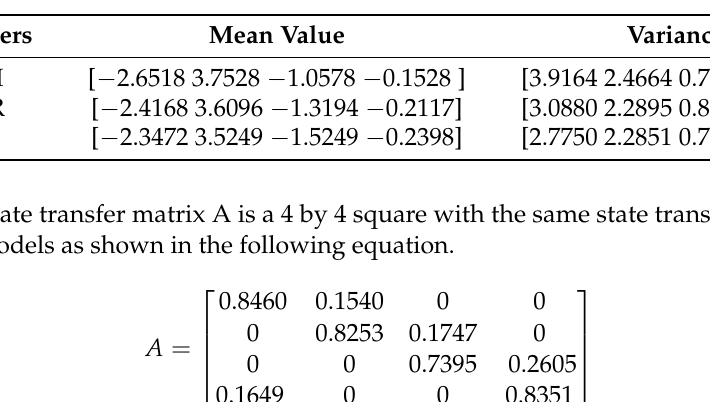
Table 2. Comparison of performance indicators.